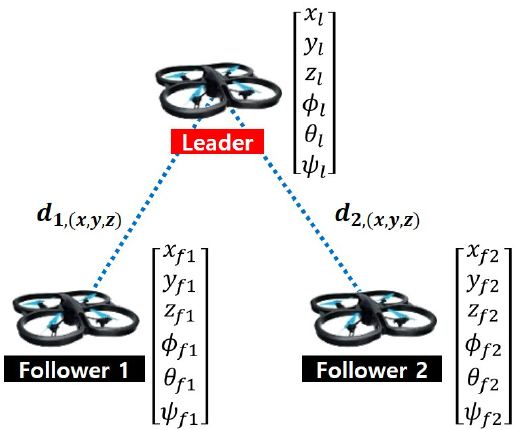
Figure 3. Leader follower structure for the formation of